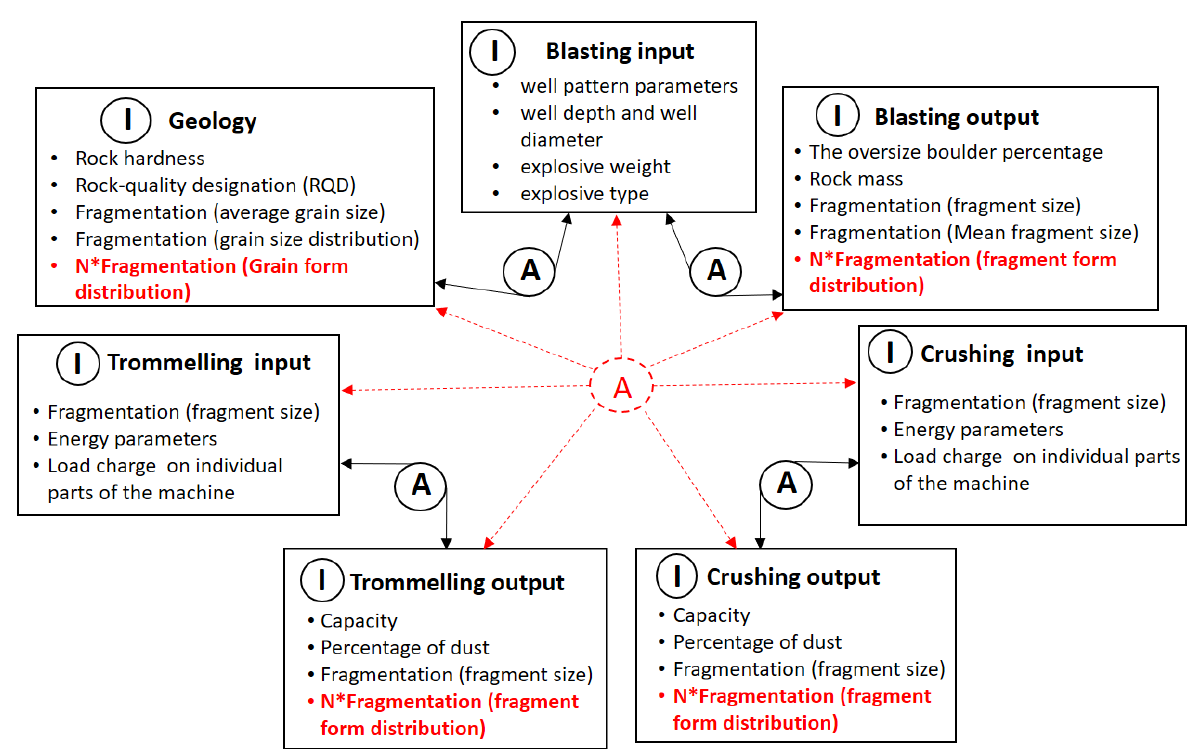
Figure 2. Scheme of the information-analytical model. I and A are the two components of this model. Component I describes the information model and a list of the main variables. Additional parameters of the existing model are highlighted in red with N*. Black, solid lines highlight operations that are typical for mining enterprises.